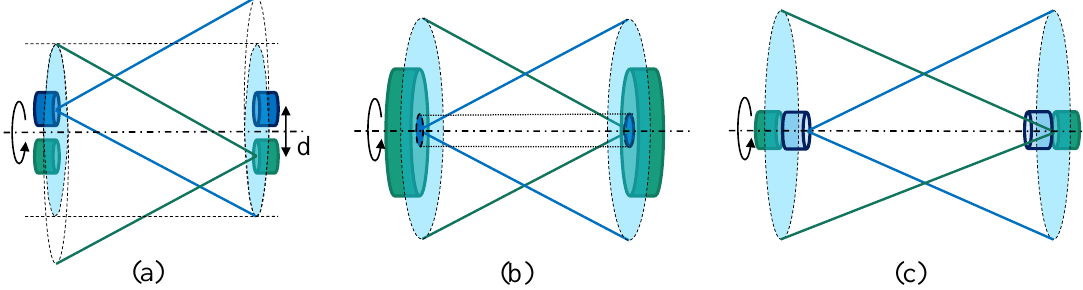
Figure 2. Schematic illustration of arrangements of separated TX (blue) and RX (green). ( a ) TX and RX are placed next to the rotation axis. The FOV of TX and RX overlap only partially. ( b ) TX and RX are placed at the optical axis and they are separated in radial direction. ( c ) TX and RX are placed in a line along the optical axis and the front element is